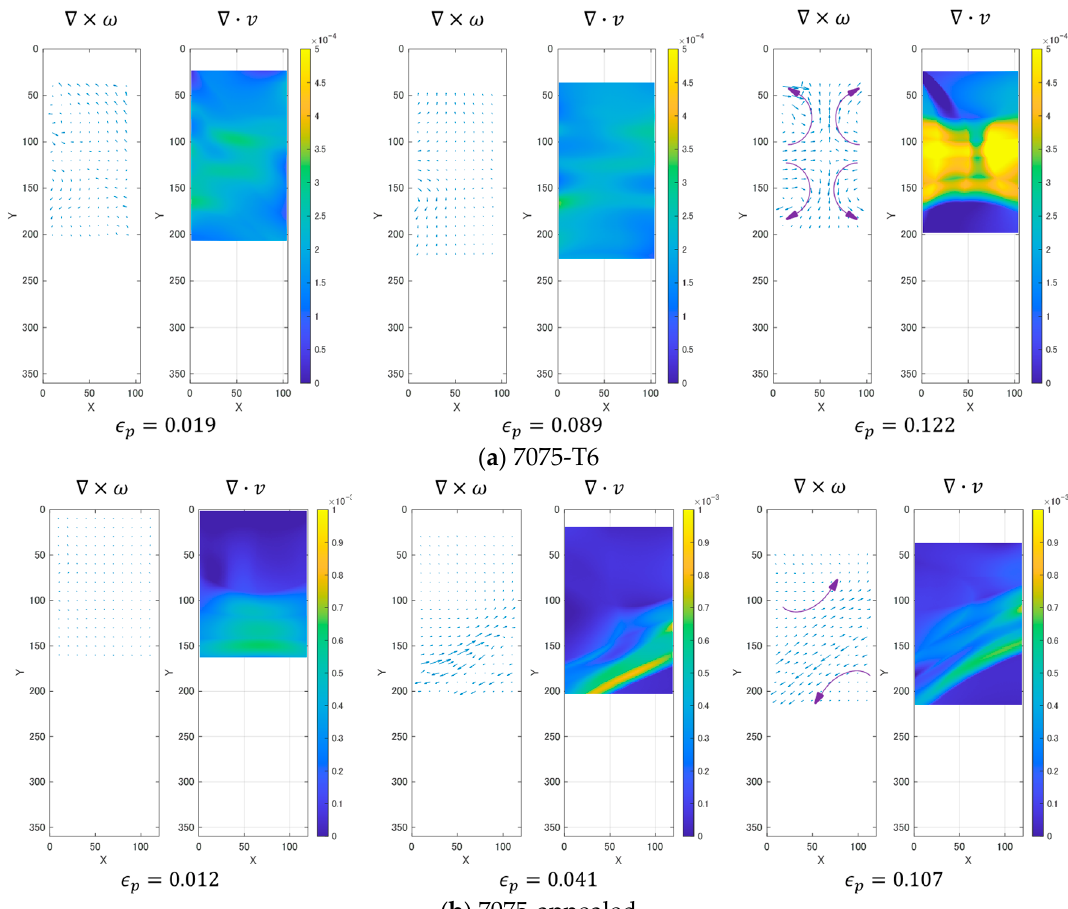
ω∇× Figure 10. Typical map in the plastic deformation processes. Figure 10. Typical ∇ × ω map in the plastic deformation